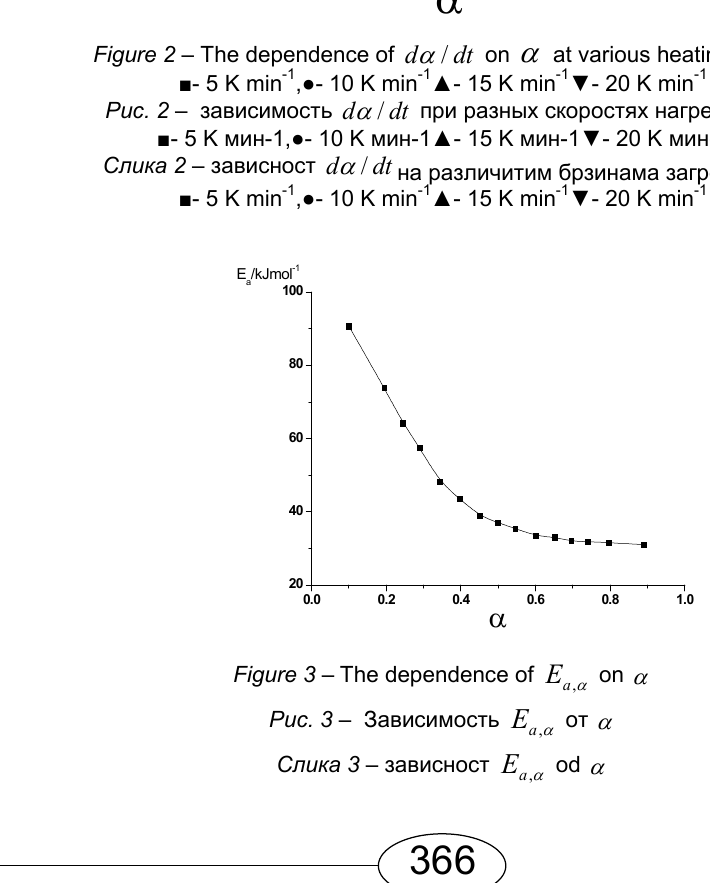
Figure 3 – The dependence of Рис . 3 – Зависимость Слика 3 – зависност